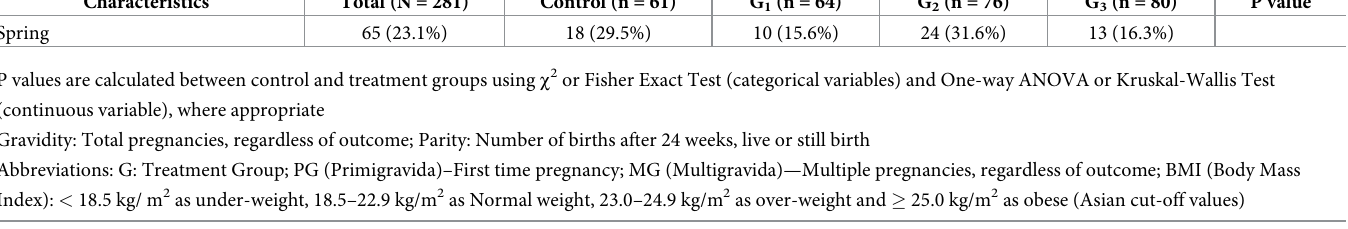
To identify possible risk factors of vitamin D insufficiency among pregnant women, a series of logistic regression analysis was performed for clinically relevant and statistically tested vari- ables (Table 6). Out of five tested variables, average daily sun-exposure (OR: 14.8, p = 0.009) and use of sunblock (OR: 4.4, p = 0.045) were two factors with a higher likelihood of vitamin D insufficiency. Patients with average daily sun exposure less than 15 minutes and those using sun block while going outside presented a higher risk of vitamin D insufficiency in this study. Seasonal variation was adjusted as covariate, there was no significant result of season on the baseline vitamin D levels.